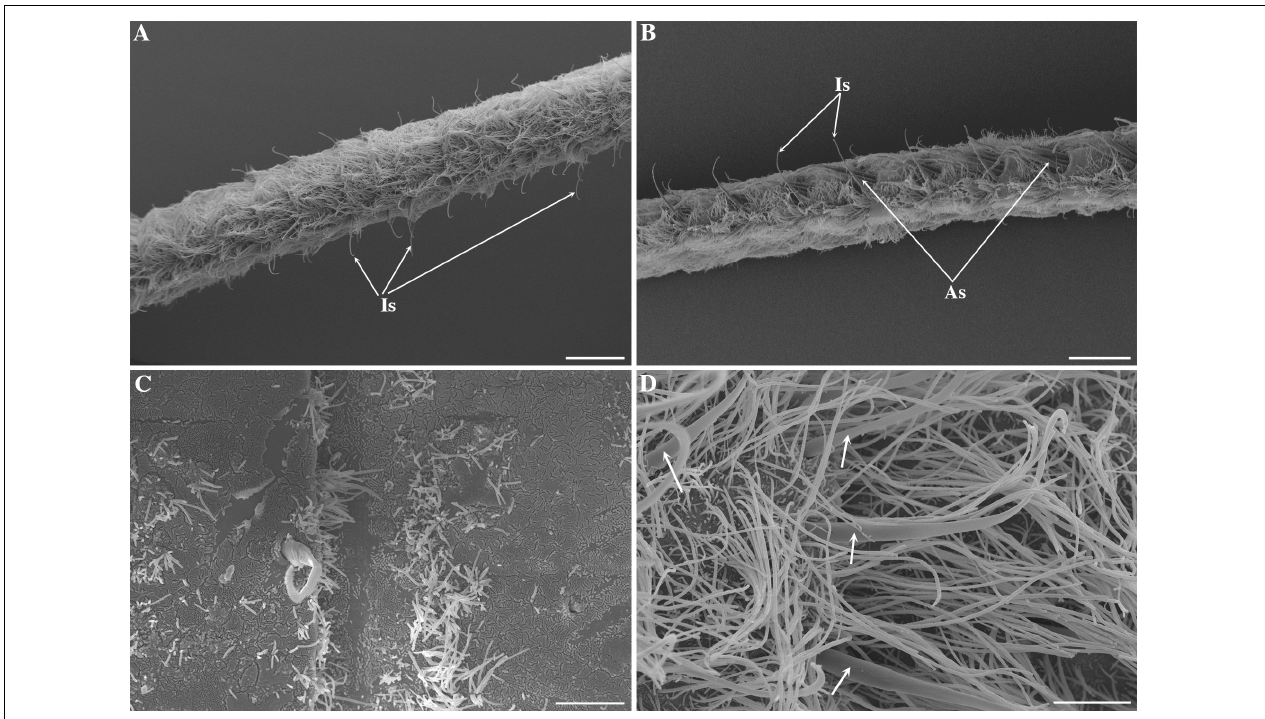
FIGURE 2 | Scanning electron micrographs of Mirocaris fortunata antennules. Medial (A) and lateral (B) antennular flagellum completely covered by filamentous bacteria. Intermediate seta (Is) and aesthetasc (As) are visible among the bacterial filaments. (C) Close-up of the base of the antenna showing patches of